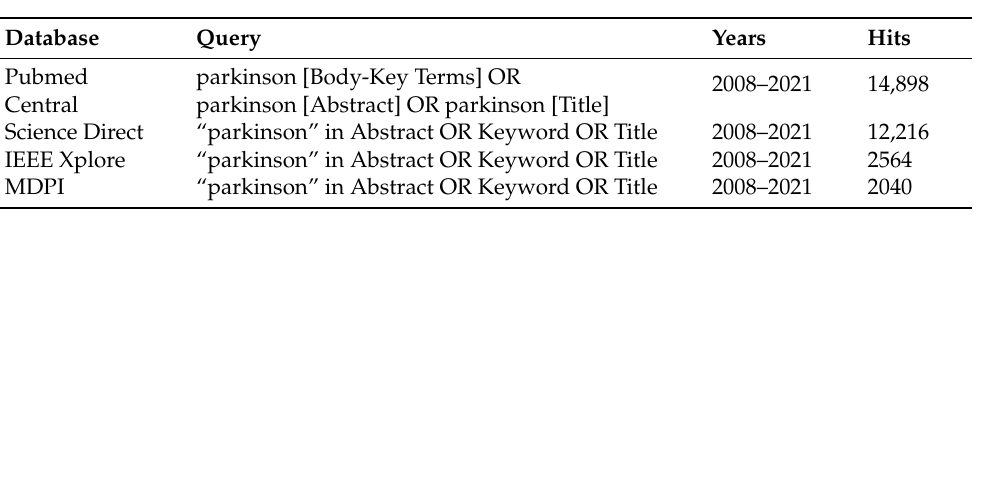
Table 2. Search queries used for each